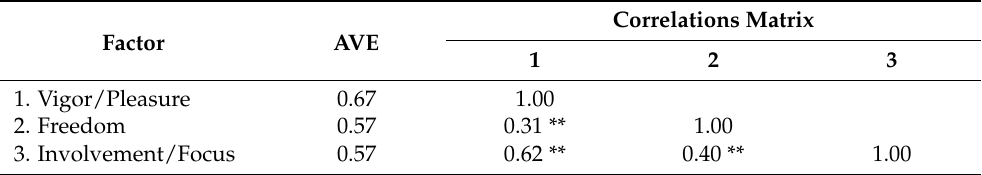
Table 4. Mean (M), standard deviation (SD), and squared factor correlations. Factor AVE